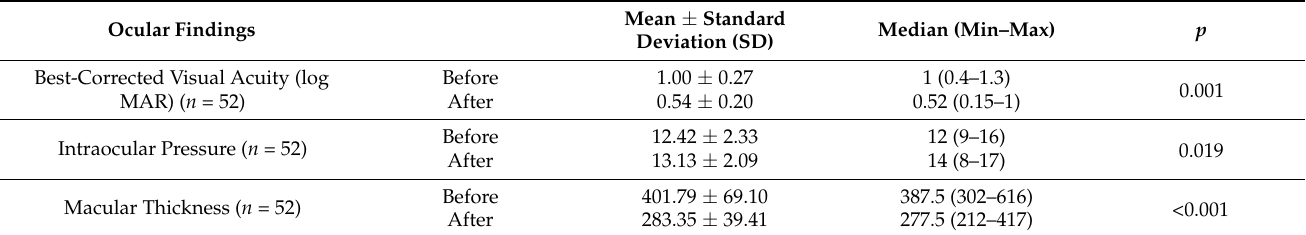
Mean ± Standard Median (Min–Max) p Deviation (SD)